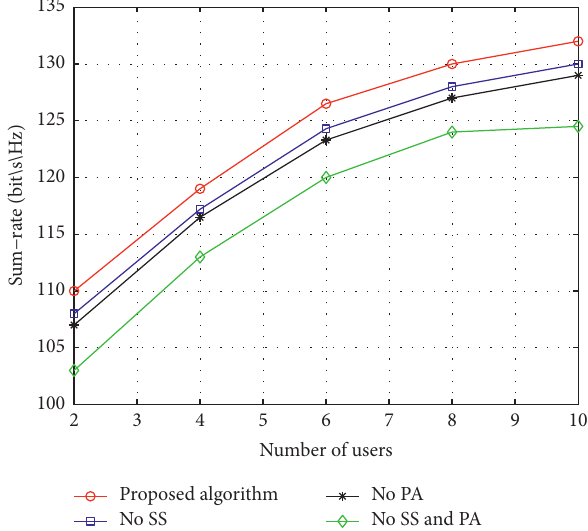
Figure 2: System sum rate for different numbers of D2D